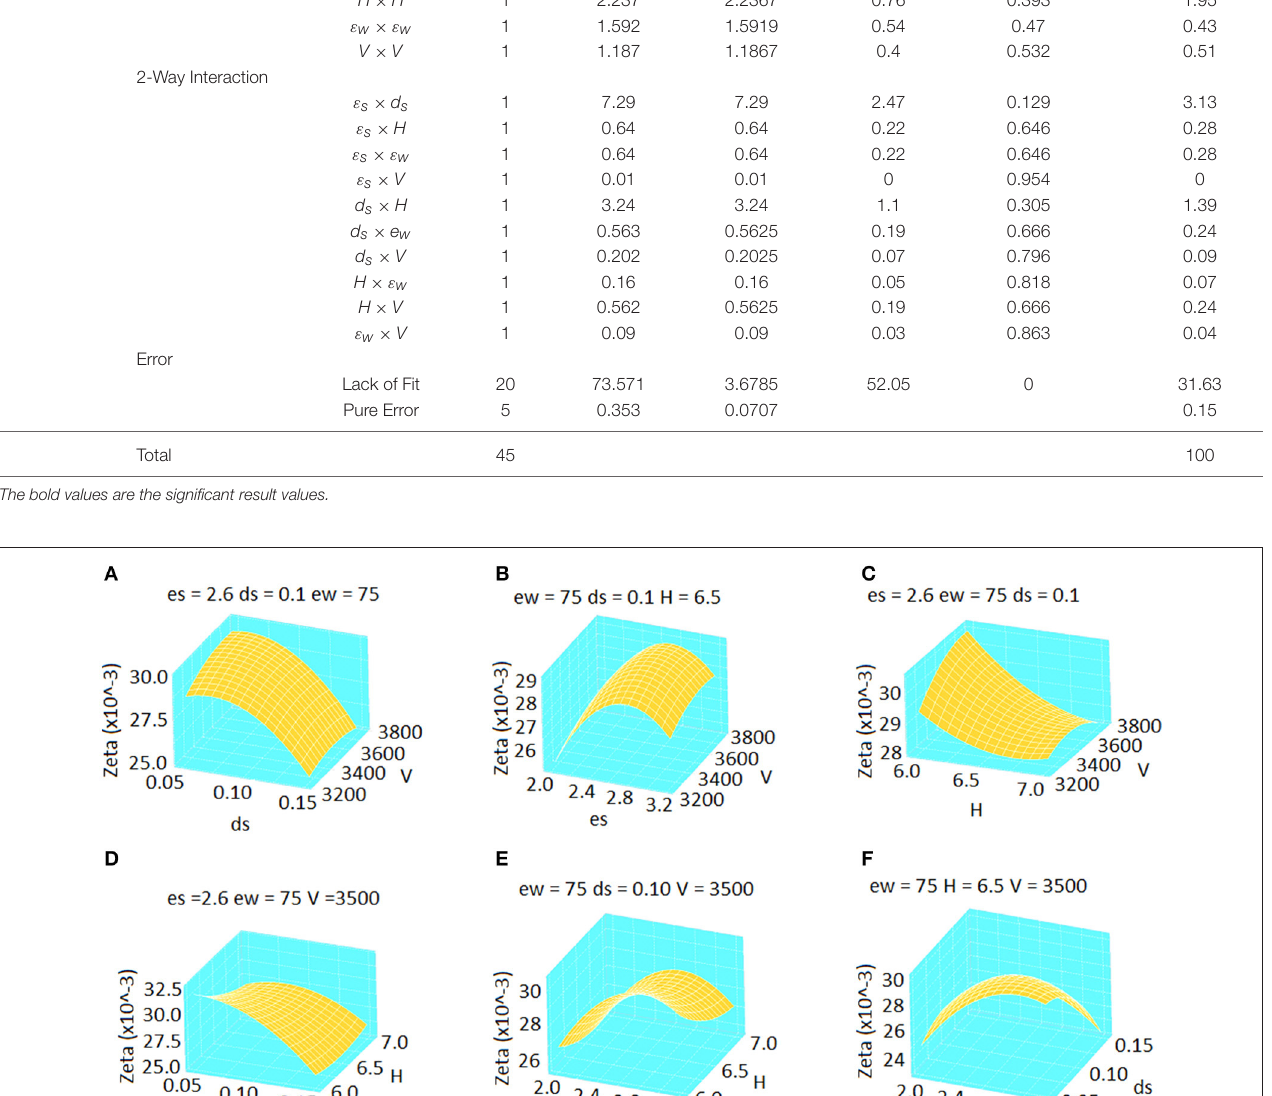
Frontiers in Materials |